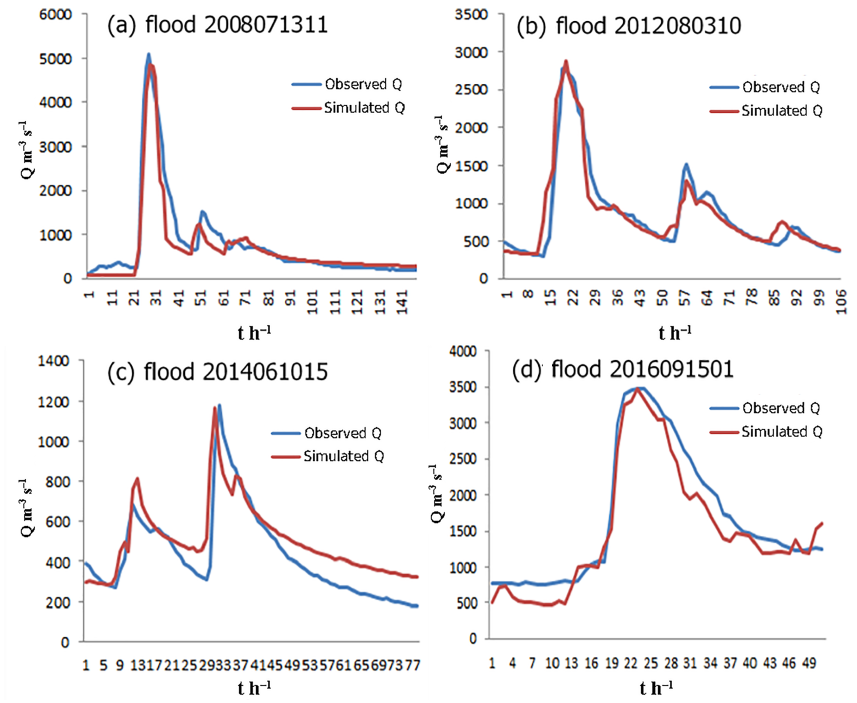
Figure 13. Karst flood simulation results from the Liuxihe model in the Beijiang